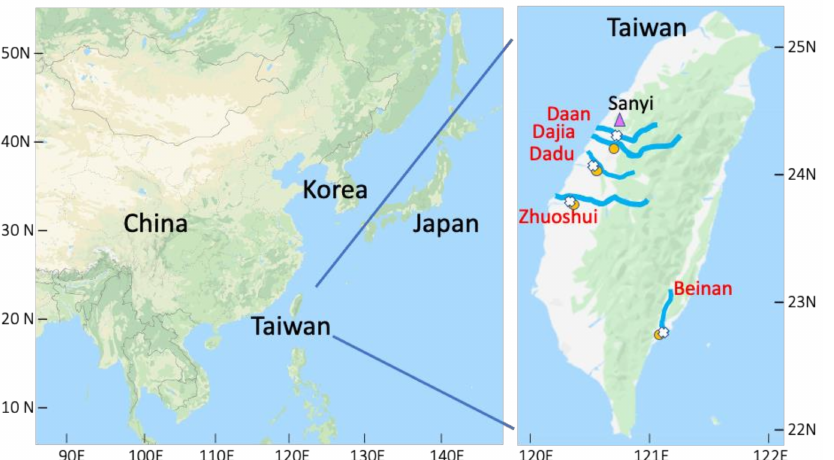
Figure 1. Locations of five major rivers in Taiwan, including the Daan, Dajia, Dadu, Zhuoshui, and Beinan. Riverbed monitoring stations are marked with a white x, EPA monitoring stations in towns nearby the riverbed stations are marked with an orange circle, and the Sanyi background station in Central Taiwan is marked with a pink triangle (Created from Google